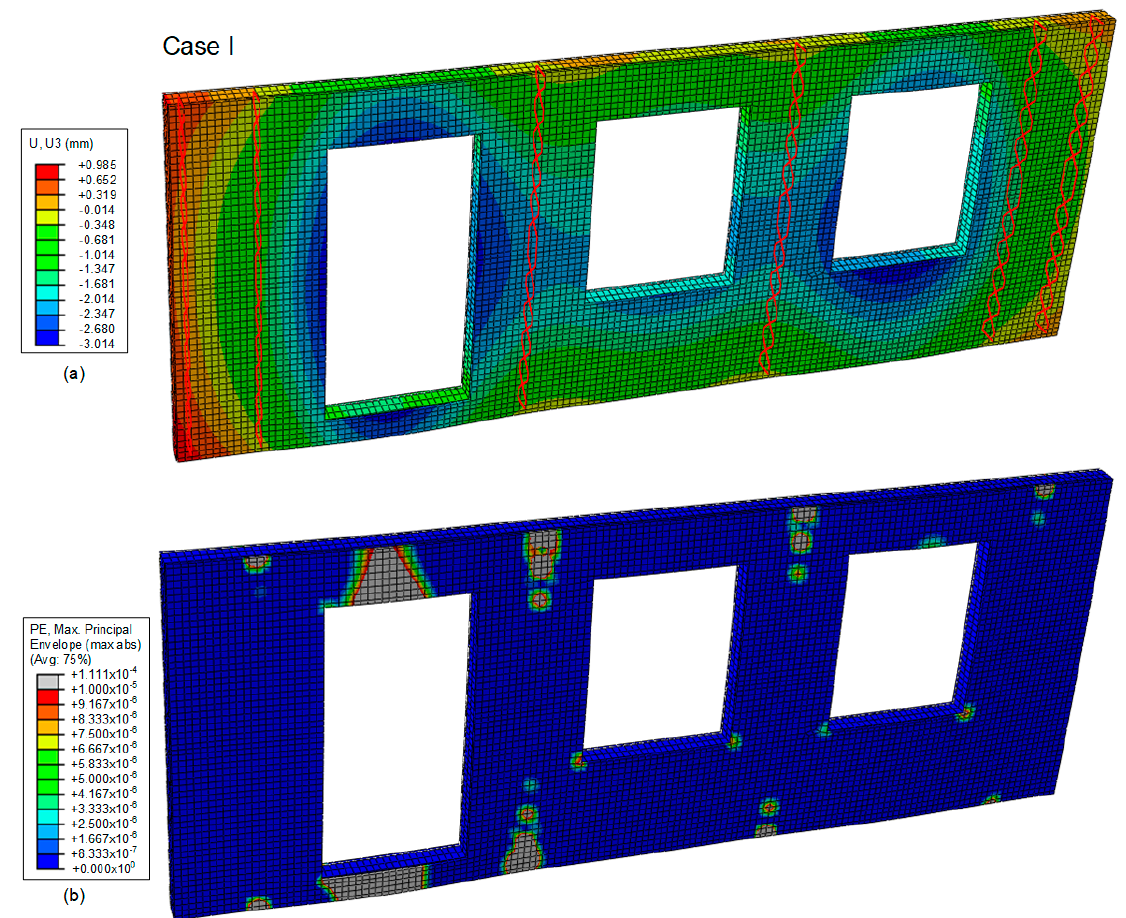
Figure 17. Case I: Contour plots of out-of-plane displacement (connectors in red) ( a ) and cracked regions at the SLS ( b ).